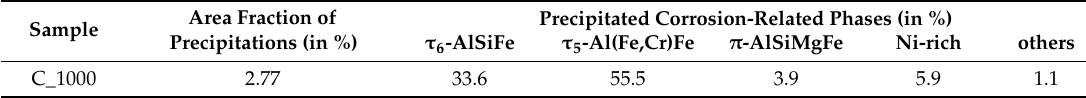
Table 18. Area fraction and proportion of corrosion-related phases precipitated in AlSi7Mg0.3.